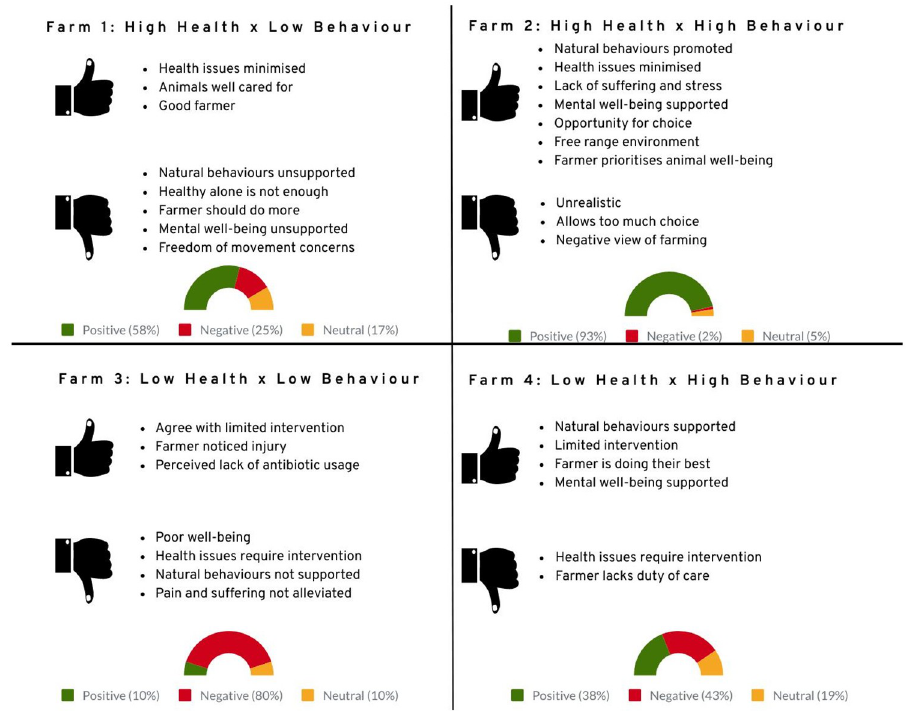
Fig 3. Sentiment analysis of qualitative responses of reasons given for well-being ratings. Responses to (ii) what participants would change about the vignette scenario are represented by the word clouds of Fig 4; the size of each word indicates the commonality of particular factors participants would